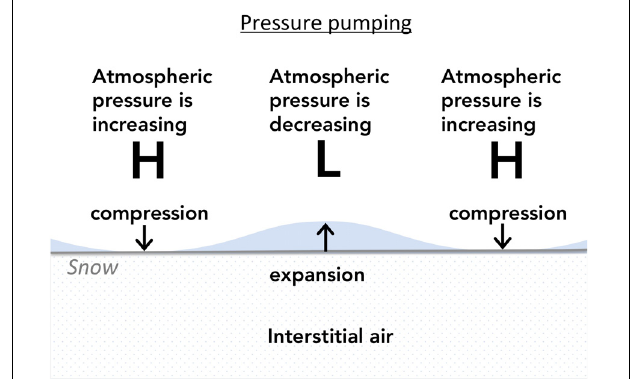
FIGURE 1 | Increasing pressure compresses atmospheric air into the snowpack and decreasing pressure allows saturated air (denoted in blue) near the snow surface to translate into the atmosphere. Successive pulses of influx and efflux generate an upward flux of water vapor if the air above the snow is subsaturated. As shown, the horizontal axis is spatial but could rather be